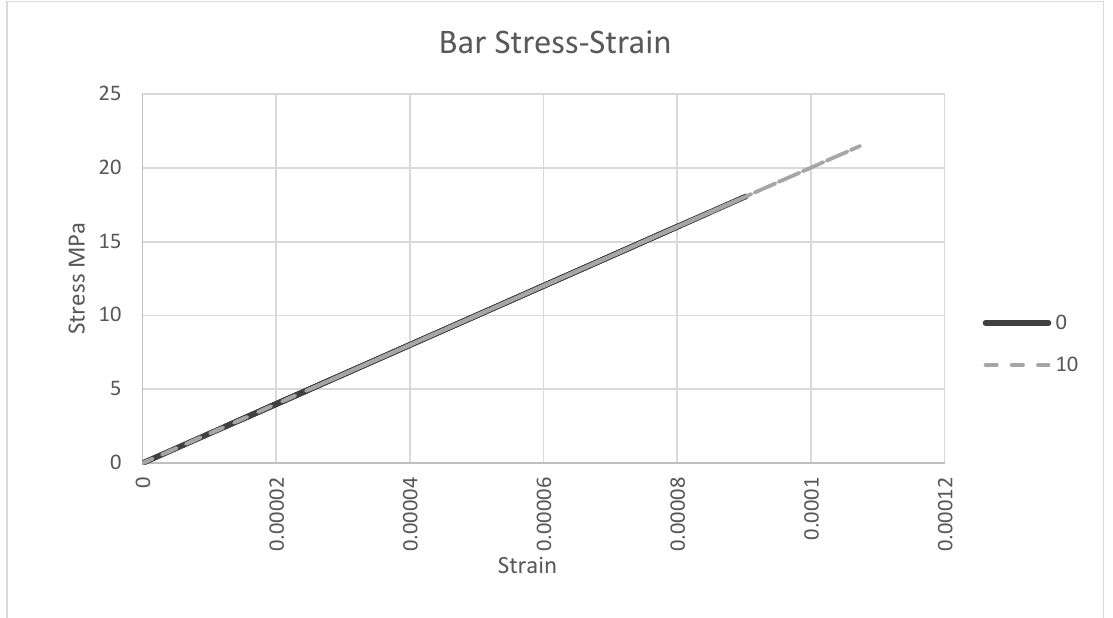
Fig. 11. Comparative stress-strain chart of the cap-beam concrete element (center the